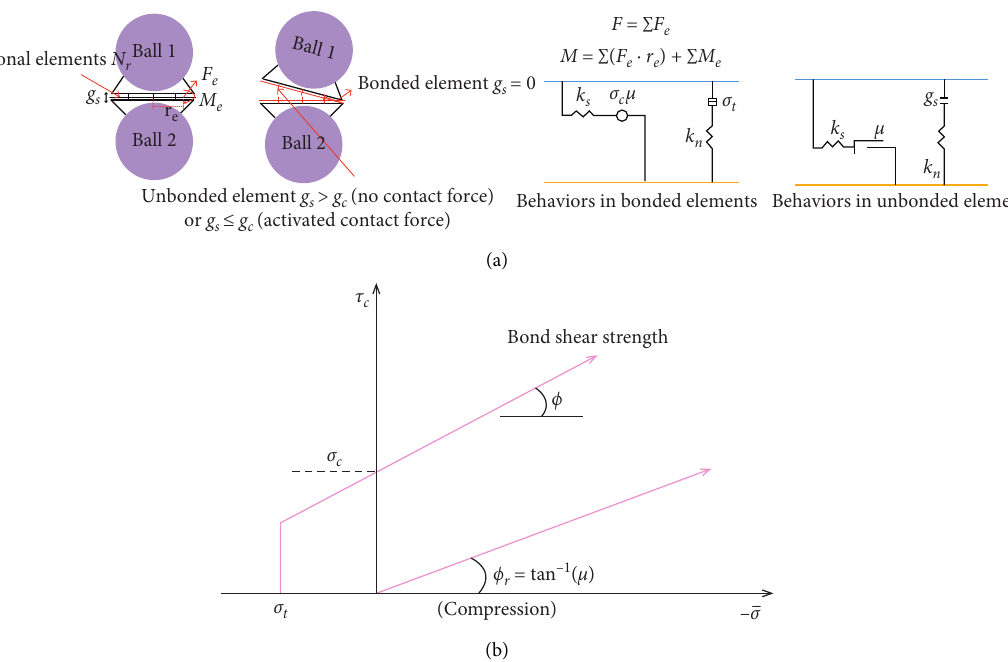
Figure 4: Flat-jointed model (FJM) for simulating the intact rock (modified from Itasca [20]). (a) Schematic diagram of the FJM. (b) Strength envelope curve of the bonded and unbonded elements. k n and k s are the normal stiffness and shear stiffness, respectively; σ c is the bonded cohesion strength; μ is the frictional coefficient; g s is the contact interface gap; g c is the contact gap; σ t is the tensile strength; and M F e and e are the force and moment of the notional elements,